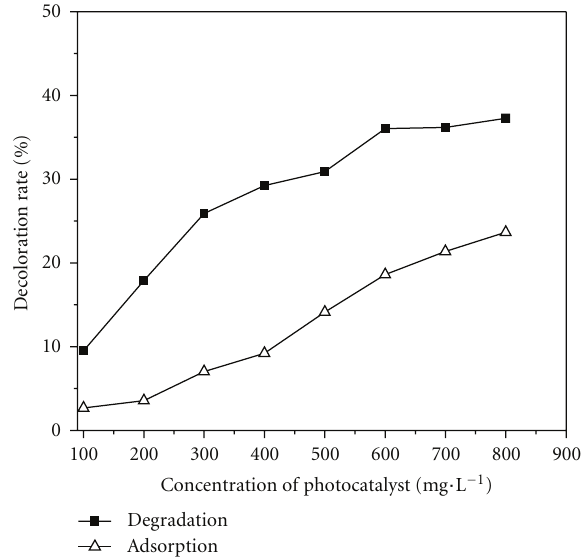
Figure 7: The e ff ect of concentration of mesoporous TiO 2 -Al 2 O 3 binary oxides (prepared at C PEG1000 = 0.03 mol/L) on methyl orange decoloration.